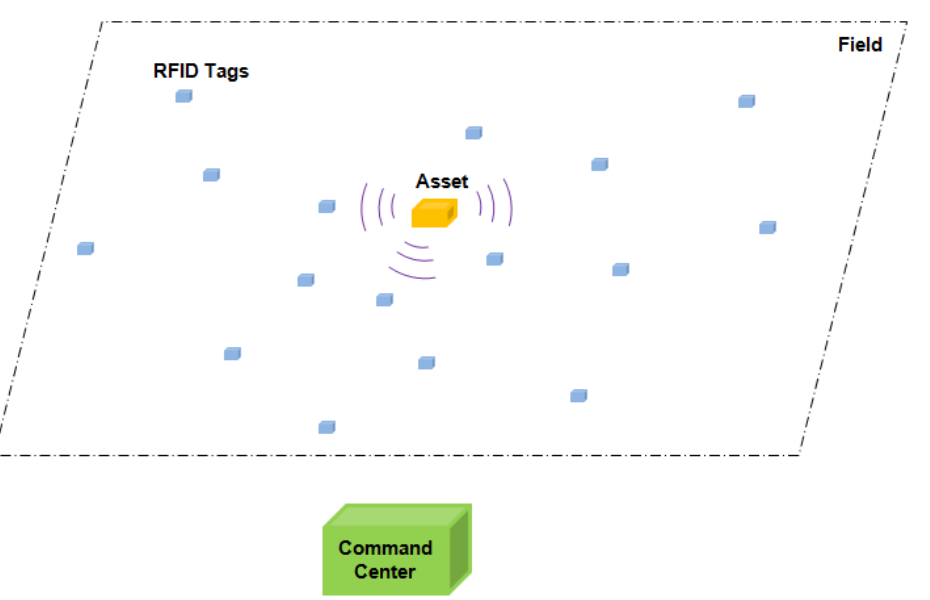
Figure 1. RFID tag application